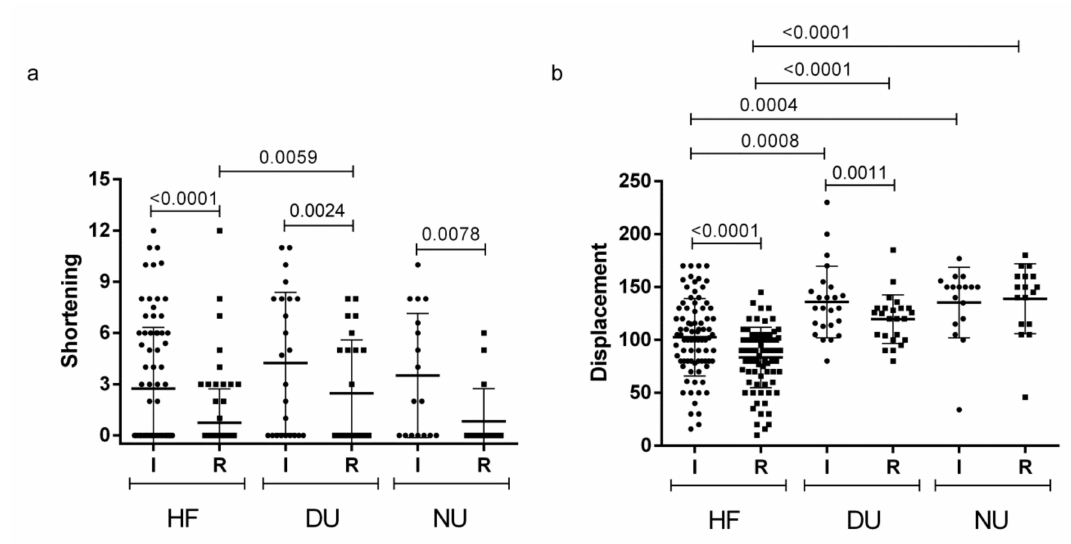
Figure 3. Initial and residual shortening ( a ) and displacement ( b ). HF = healed fractures, DU = delayed union, NU = nonunion, I = initial, R =